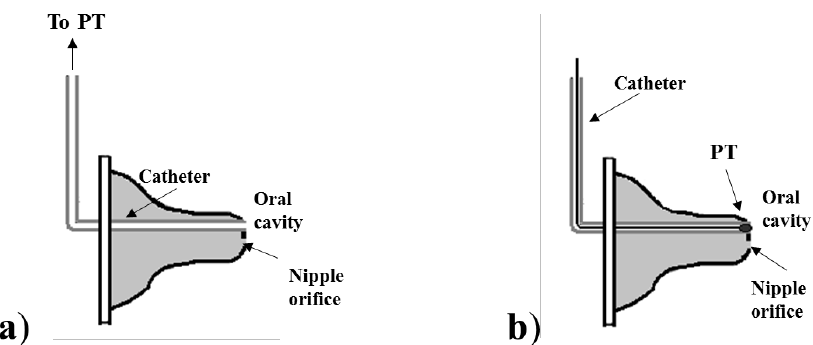
Figure 2. Schematic diagrams of a nipple designed for nutrient delivery and IP